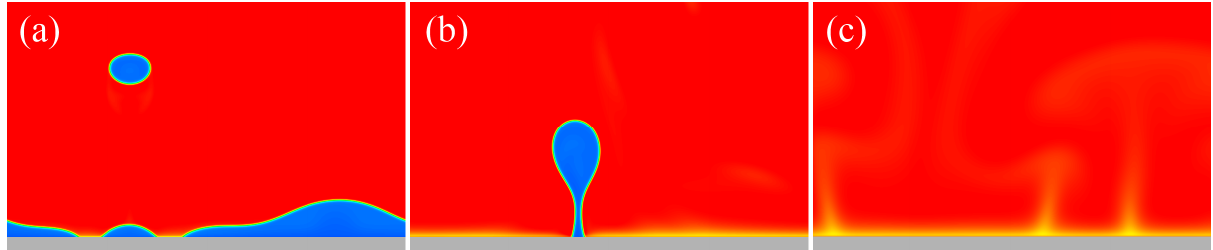
Figure 3. The density contour plots illustrating the boiling process at low surface superheat, Δ T = 0.045 T c . ( a ) lyophobic surface ( θ = 116°), ( b ) neutral surface ( θ = 90°) ( c ) lyophilic surface ( θ = 38°). ◦ ), ( b ) neutral surface ( θ = 90 ◦ ) ( c ) lyophilic surface ∆ T = 0.045 T c . ( a ) lyophobic surface ( θ = 116 ( θ = 38 ◦